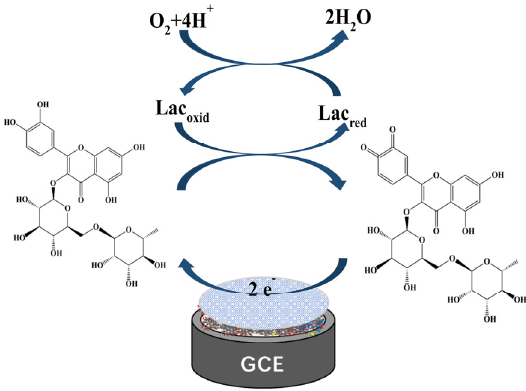
Figure 11. Schematic diagram of rutin catalyzed by Lac on the biosensor surface.